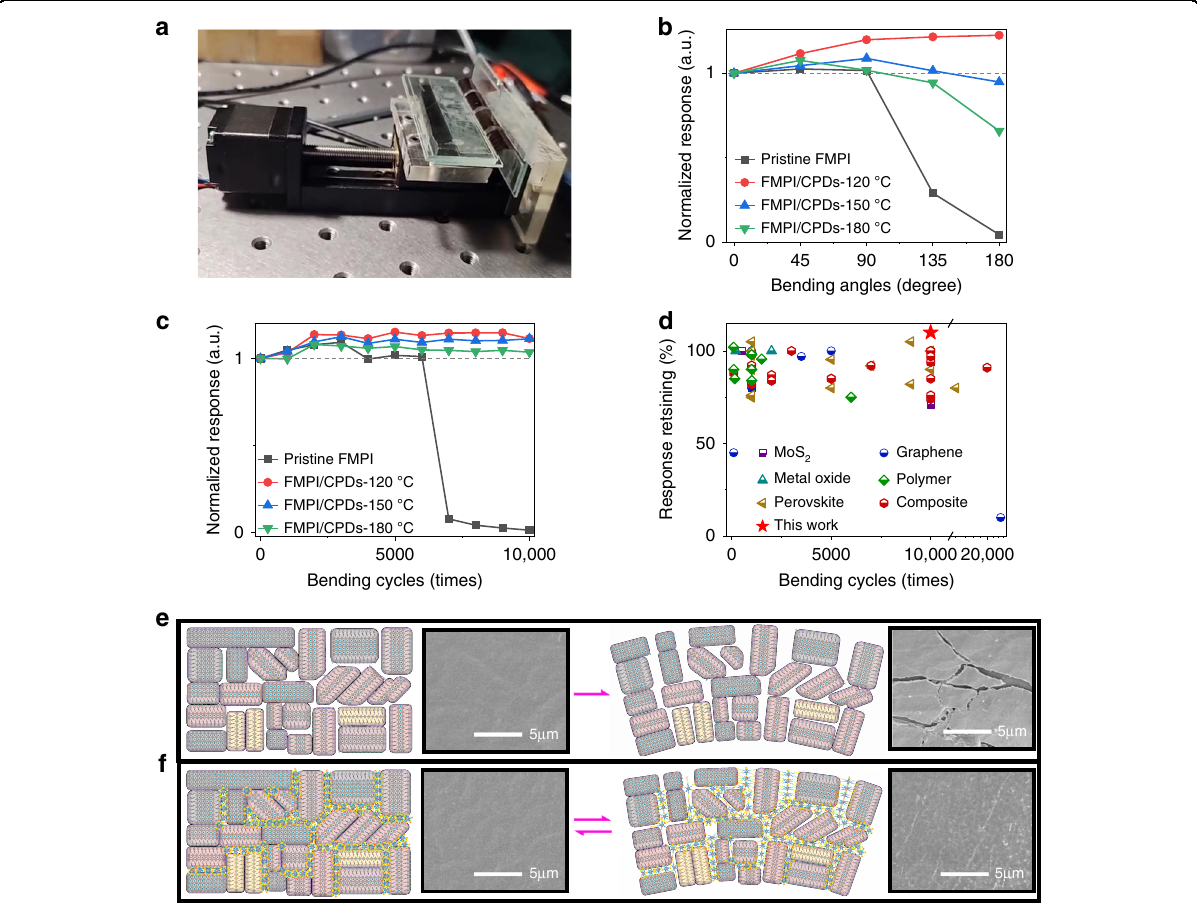
Fig. 3 Flexibility and stability of FMPI/CPDs photodetectors. a Photo of the homemade motor bending system. The fl exible stability of various bending angles ( b ) and bending times ( c ). d Plots of bending stability for fl exible optoelectronic devices reported. e Schematic diagram of pristine FMPI thin fi lm before and after bending process, with SEM images alongside. f Schematic diagram of pristine FMPI/CPDs thin fi lm before and after bending process, with SEM images